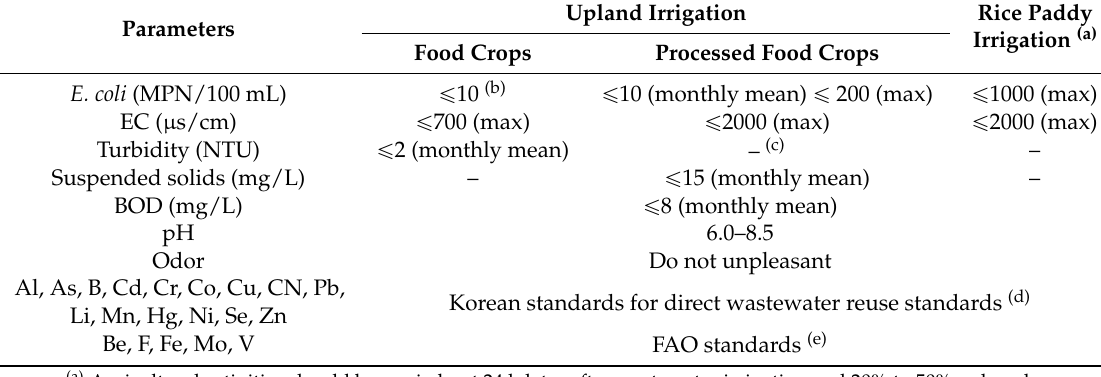
Table 5. A draft proposal for the water quality standards of indirect wastewater reuse in South